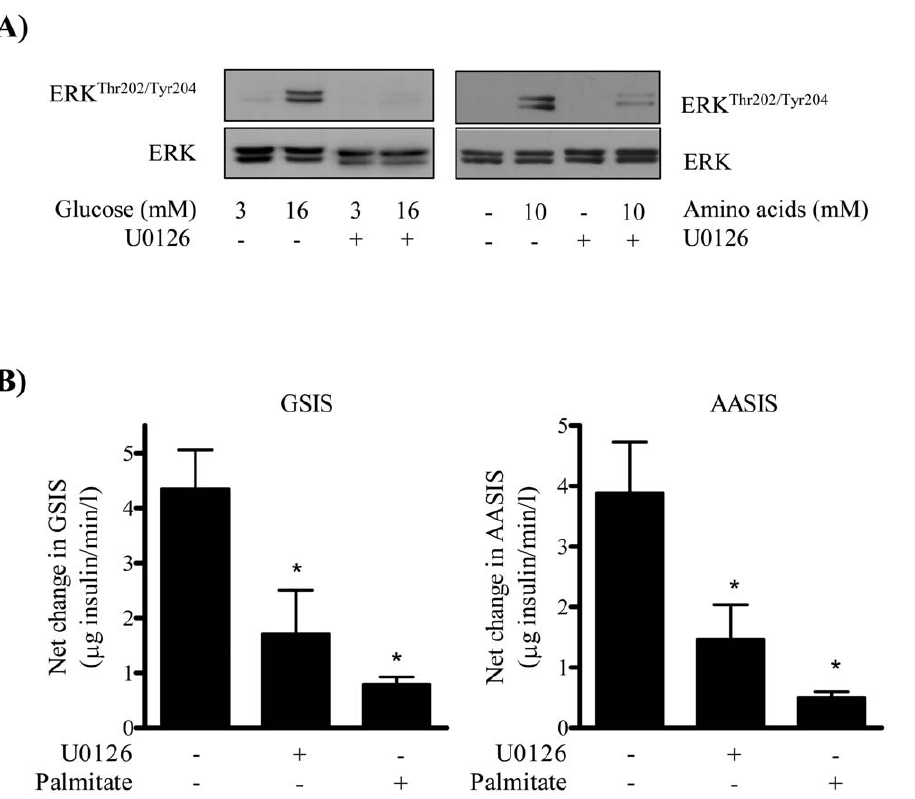
Figure 5. ERK inhibition induces a loss in glucose-stimulated insulin secretion (GSIS) and amino acid-stimulated insulin secretion (AASIS). MIN6 b cells were incubated in the absence or presence of 20 m M U0126, as indicated prior to being exposed to either 3 mM or 16 mM glucose for 1 h or alternatively to an amino acid stimulus (10 mM leucine/glutamine and 3 mM glucose). At the end of this incubation cells were (A) lysed for analysis of ERK phosphorylation in whole cell lysates or (B) prepared for analysis of net changes in GSIS or AASIS (B) as described in methods. Bars represent mean 6 SEM from 3 separate experiments and asterisks signify a significant difference from the untreated control values (P , 0.05).